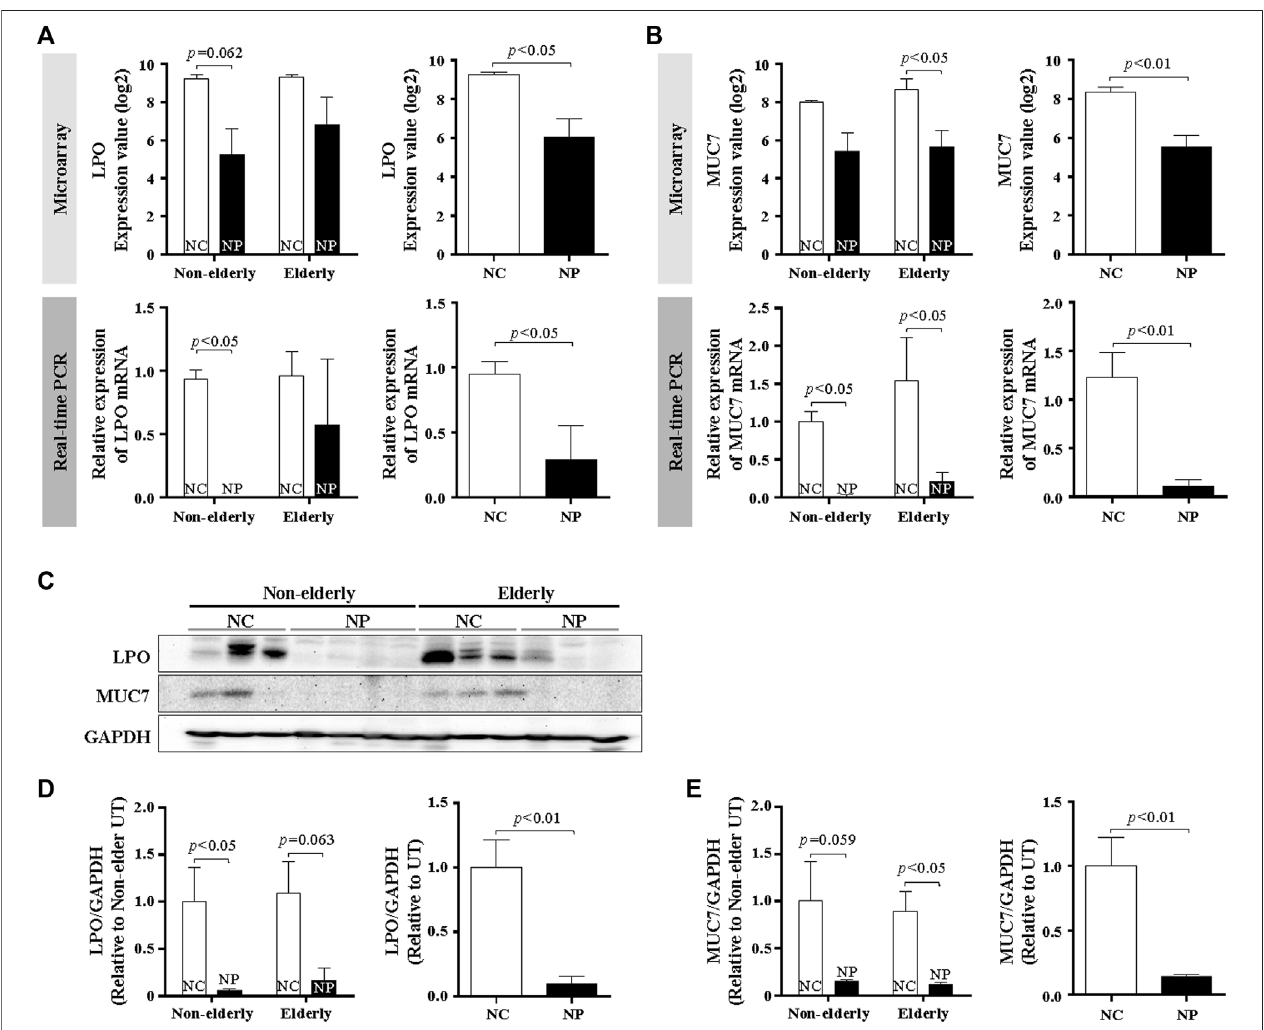
FIGURE3| MUC7andLPOexpressioninthesinonasaltissuesfromsubjectswithNPandnormalcontrols (A,B) ValidationofmRNAexpressionofselectedgenes, LPO, and MUC7 from microarray data by real-time PCR. Data are expressed as the means ± SE (NC versus NP, n = 16, LPO and MUC7, p < 0.05 and p < 0.01, respectively). (C) ValidationofresultsusingWesternblotanalysisoftissueextractsfromNPandnormalcontrolsubjects.RepresentativeWesternblotsforeachantibody are shown. (D,E) Quanti fi cation ofband intensities for each represented blotwas performed using ImageJ. Data areexpressed asthe means ± SE(NC versus NP, n = 13, p < 0.01). NC, normal control; NP, nasal